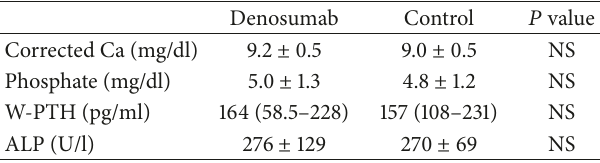
Table 2: Baseline parameters of the